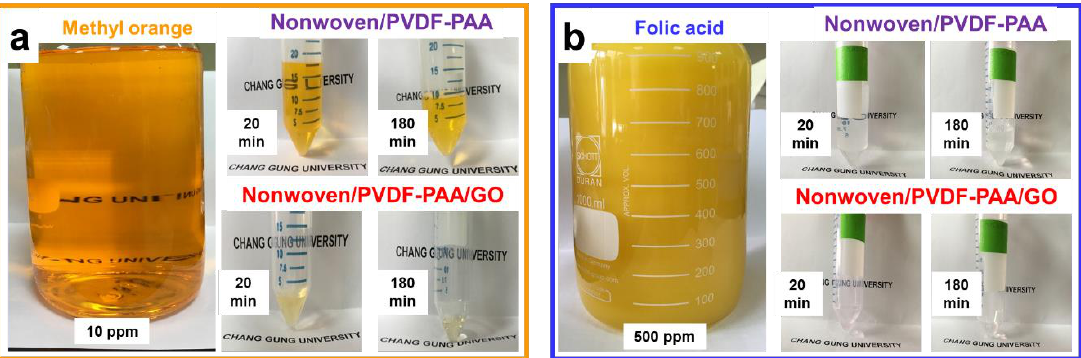
Figure 8. Photographs of ( a ) methyl orange and ( b ) folic acid permeate solutions during various filtration times through nonwoven/PVDF-PAA and nonwoven/PVDF-PAA/GO composite membranes, respectively.